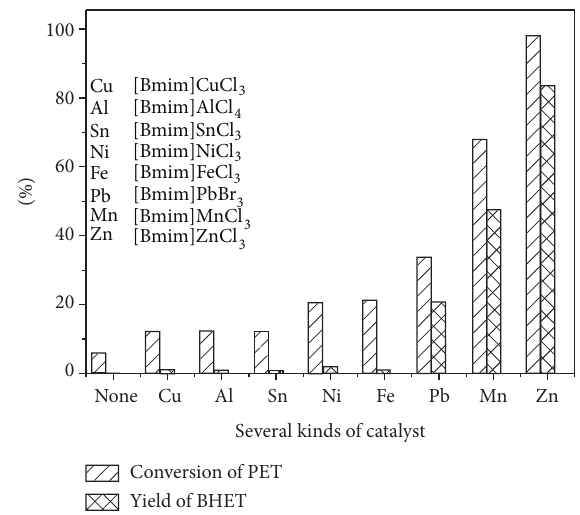
Figure 4: The effect of different catalysts on the glycolysis of PET. Reaction conditions: PET 2 g, catalyst 1wt%, reaction time 5 h, and temperature 180 ∘ C.